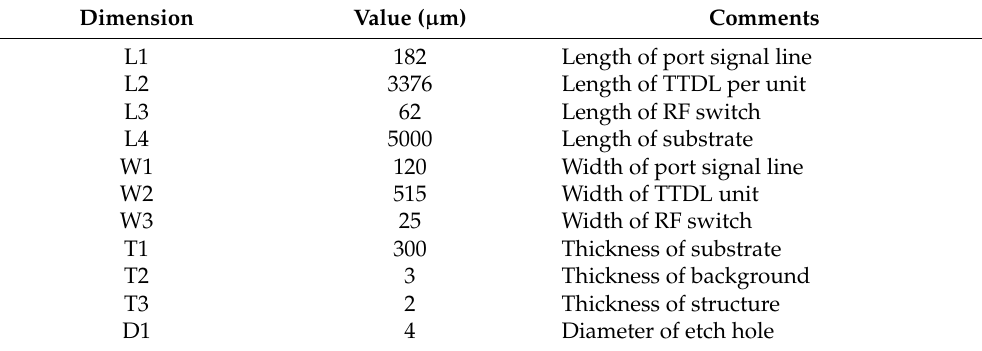
Table 2. Structural parameters of the TTDL network.